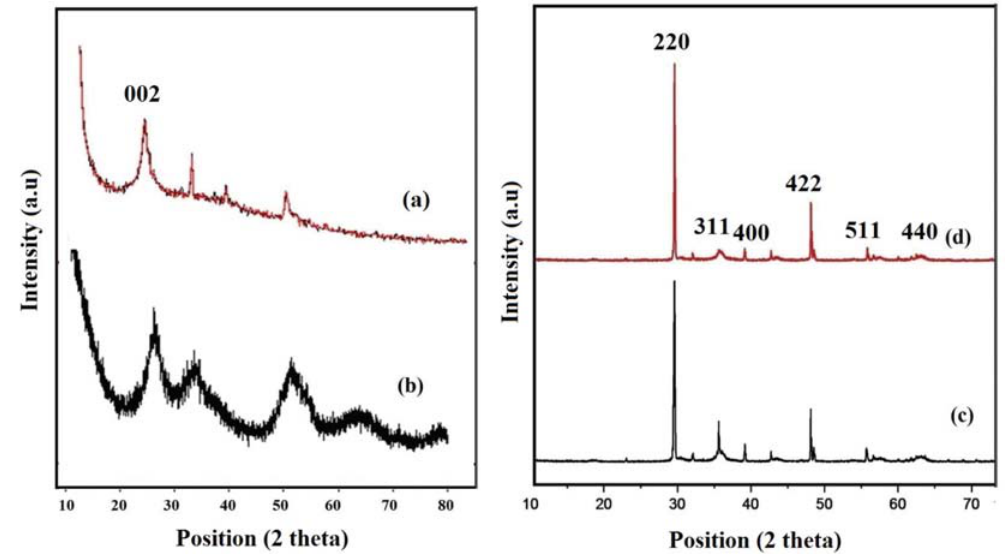
Figure 1. PXRD patterns of (a) GO, (b) NG, (c) NiFe